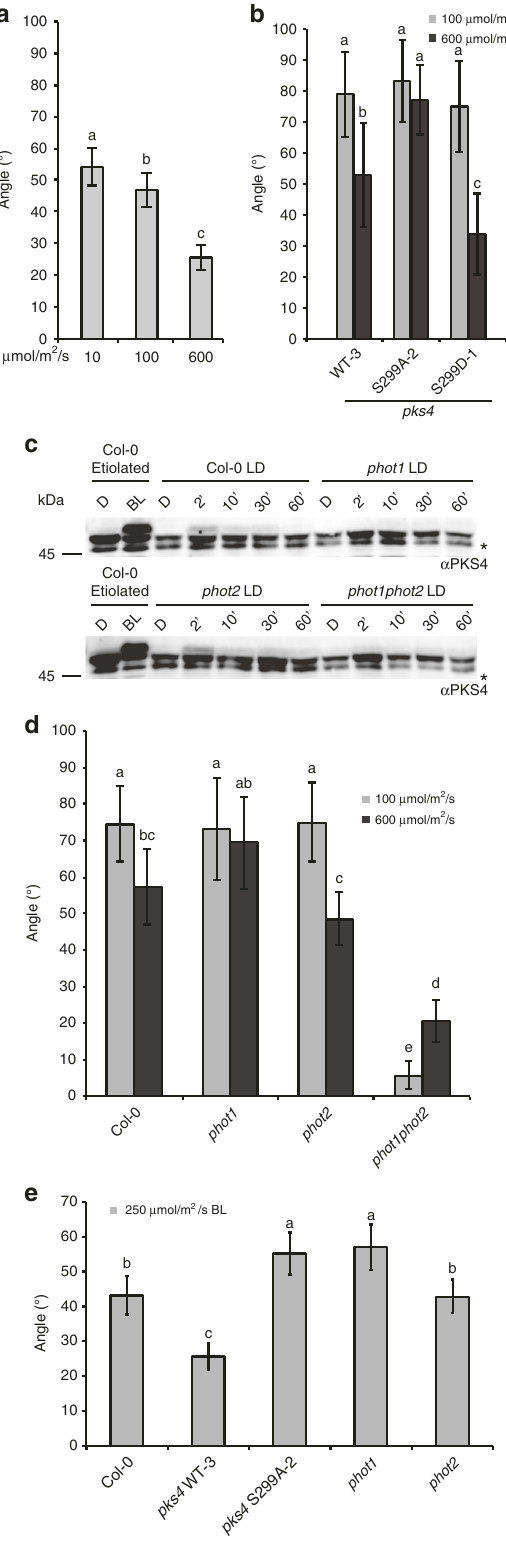
600 µ mol m − 2 s − 1 unilateral blue light for 3 h prior to measurements. n = 68 − 97. b Phototropic curvature of pks4 PKS4-WT-3, pks4 S299A-2, and pks4 S299D-1 seedlings treated with 100 or 600 µ mol m − 2 s − 1 unilateral blue light for 6 h prior to measurements. n = 25 − 43. c Western blot probed with anti-PKS4 antibodies from long-day (LD) grown Col-0, phot1 , phot2 , and phot1phot2 samples exposed to 600 µ mol m − 2 s − 1 blue light for 0, 2, 10, 30, or 60 min. Samples from etiolated Col-0 seedlings are used as a control. Asterisks indicate unspeci fi c band. d Phototropic curvature of Col- 0, phot1 , phot2, and phot1phot2 seedlings treated with 100 or 600 µ mol m − 2 s − 1 unilateral blue light for 6 h prior to measurements. n = 29 − 69. e Phototropic curvature of seedlings of Col-0, pks4 PKS4-WT-3, pks4 S299A-2, phot1 , and phot2 placed in a greenhouse at ZT4, blue light was ~250 µ mol m − 2 s − 1 . Phototropic bending was measured after 1 h and 45 min. n = 109 – 154. Seedlings were grown for 3 days in a 16 – 8 h day − night cycle, the experiment started 2 h after dawn (ZT2) except for panel ( e ). Data represent means. Error bars correspond to 2× standard error. Means with same letter are not signi fi cantly different ( p > 0.05, one-way ANOVA test for ( a ) and ( e ), two-way ANOVA for ( b ) and ( d